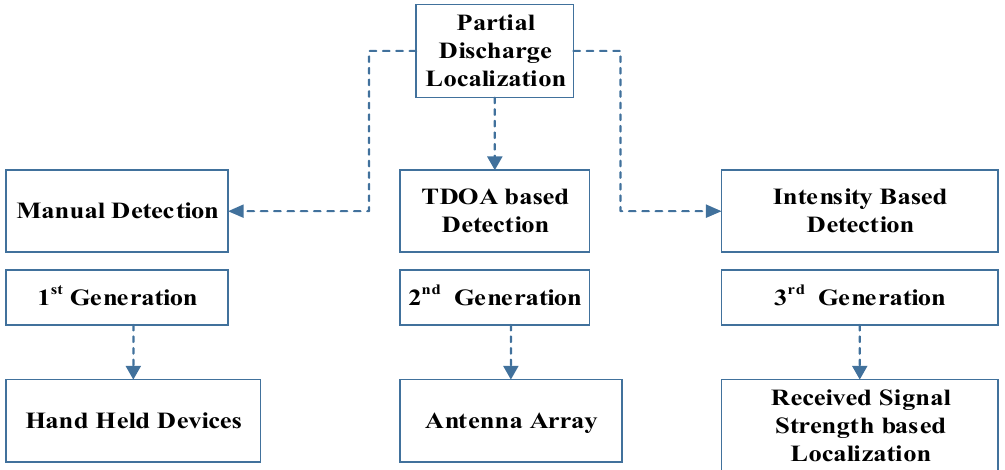
Figure 1. PD localization techniques.